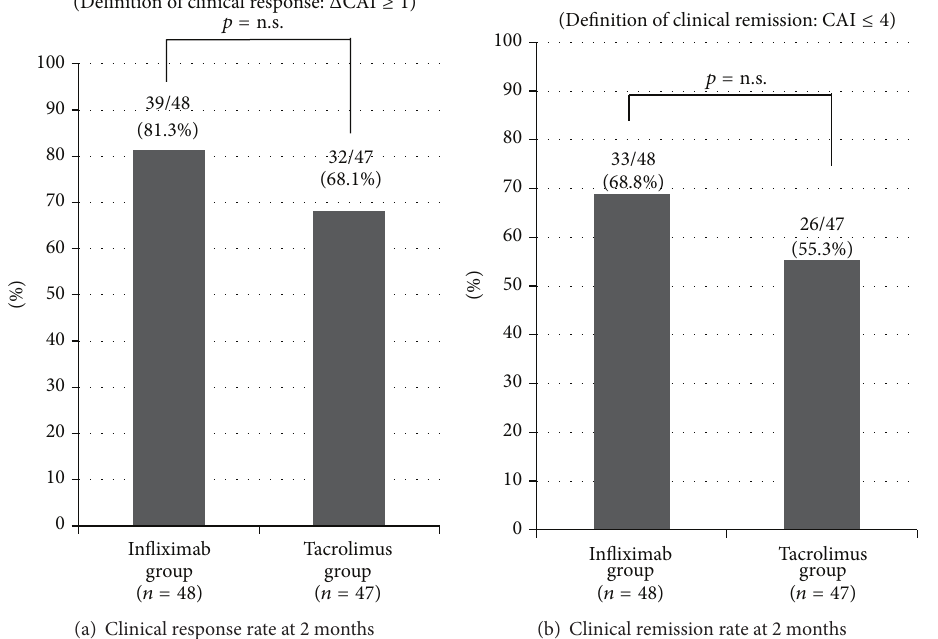
Figure 3: Clinical remission rate and clinical response rate at 2 months. (a) Clinical response rate at 2 months was 81.3% in the infliximab group and 68.1% in the tacrolimus group, without a significant difference between the two groups. (b) Clinical remission rate at 2 months was 68.8% in the infliximab group and 55.3% in the tacrolimus group, without a significant difference between the two